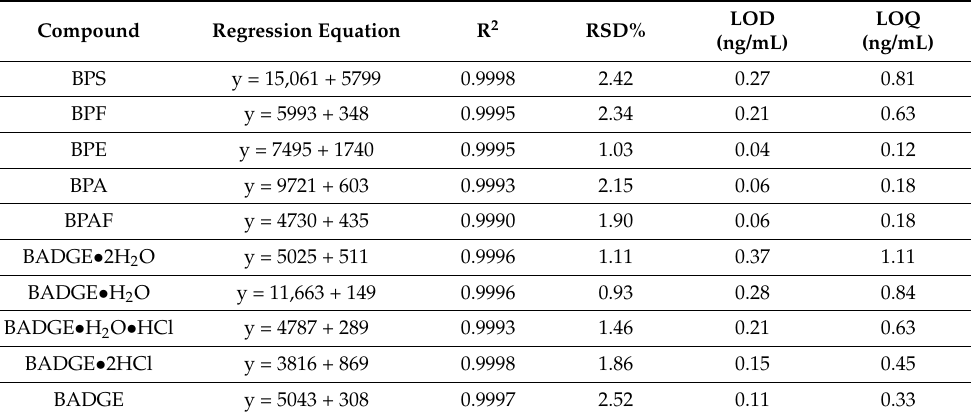
Table 2. Calibration data of detected components including: calibration equations, linearity coefficient (R 2 ), LOD, LOQ, and precision (RSD).